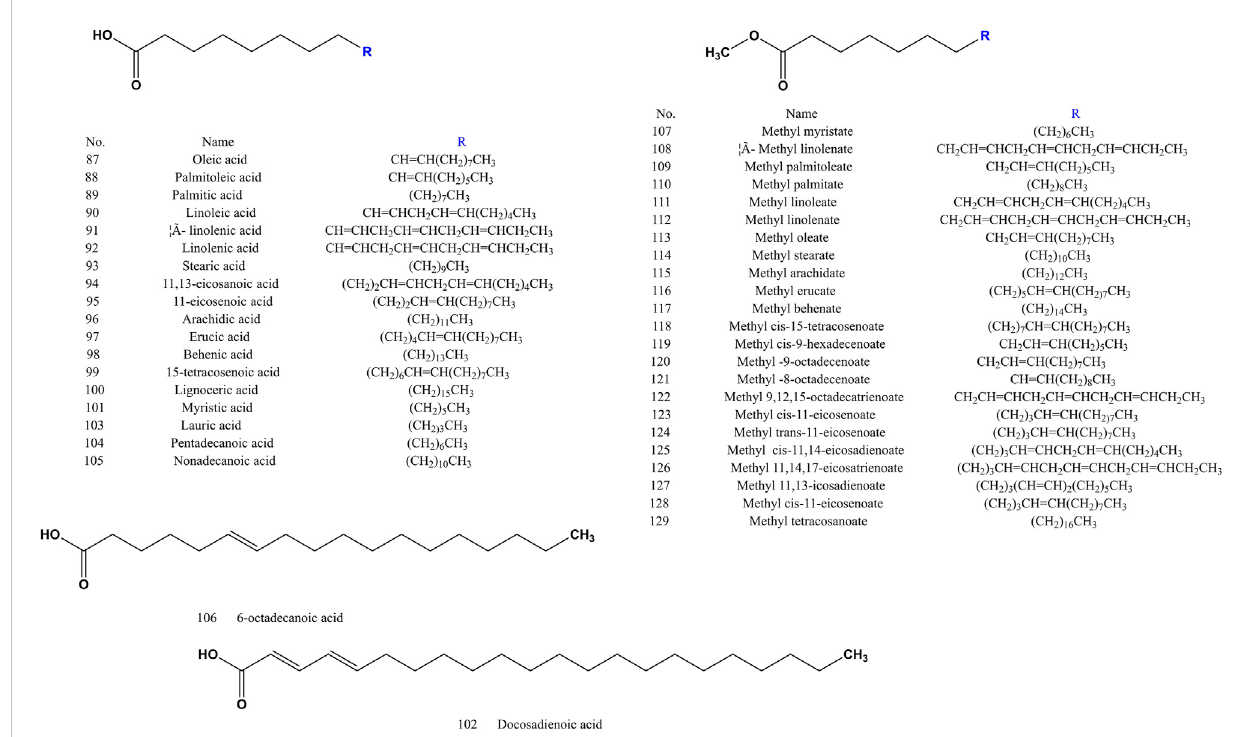
FIGURE 5 Chemical structures of fatty acids and their methyl esters identi fi ed from SS (compound 87 – 129 ).